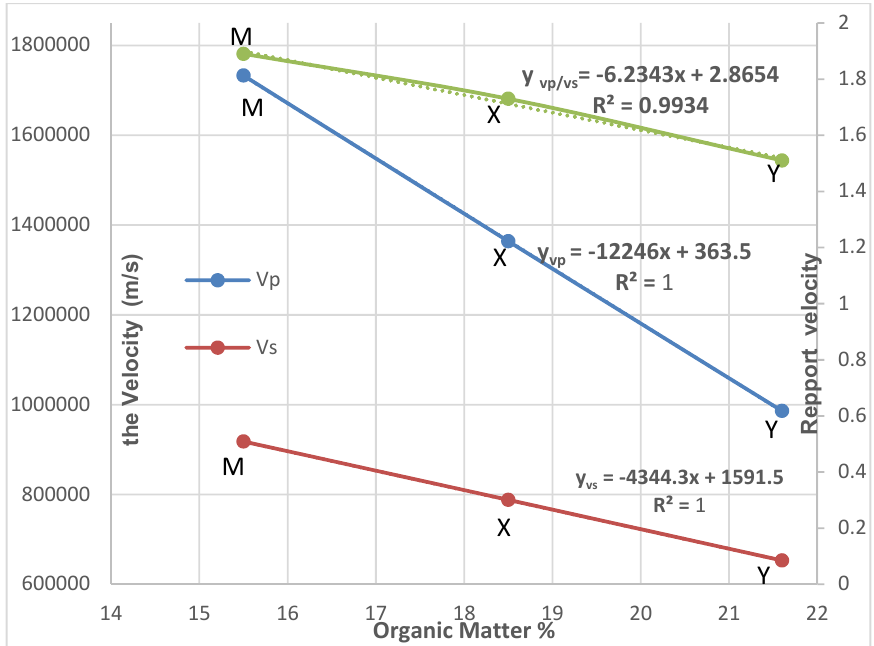
Figure 5. Variation of Velocities Vp, Vs and Vp/Vs as a function of the organic matter content of the layers.